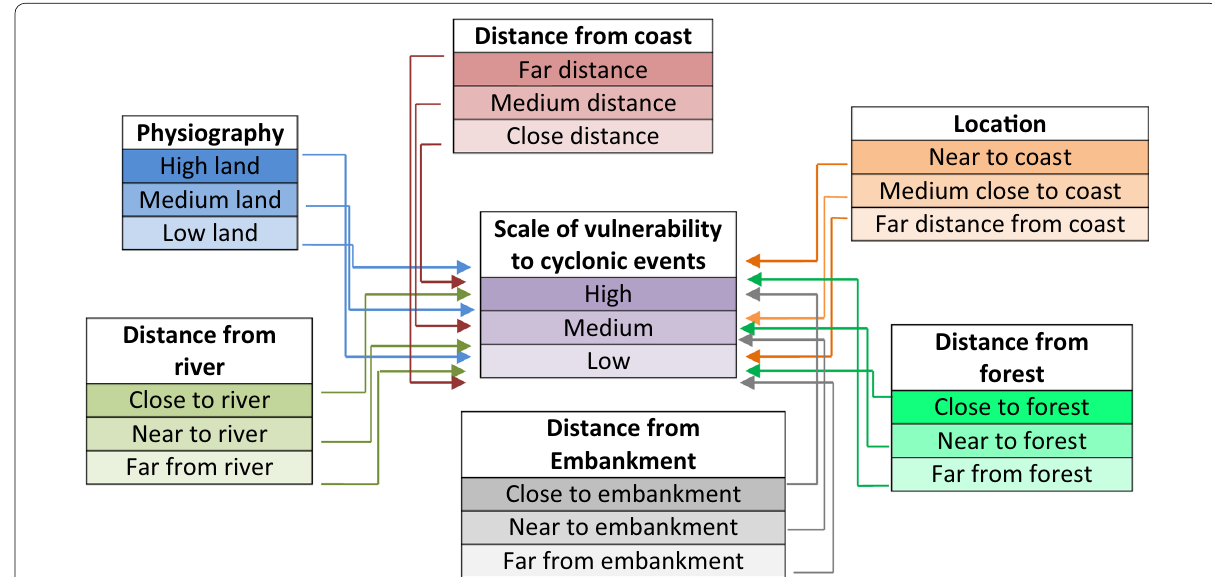
Fig. 2 Level of individual and integrated influencing factors of the study